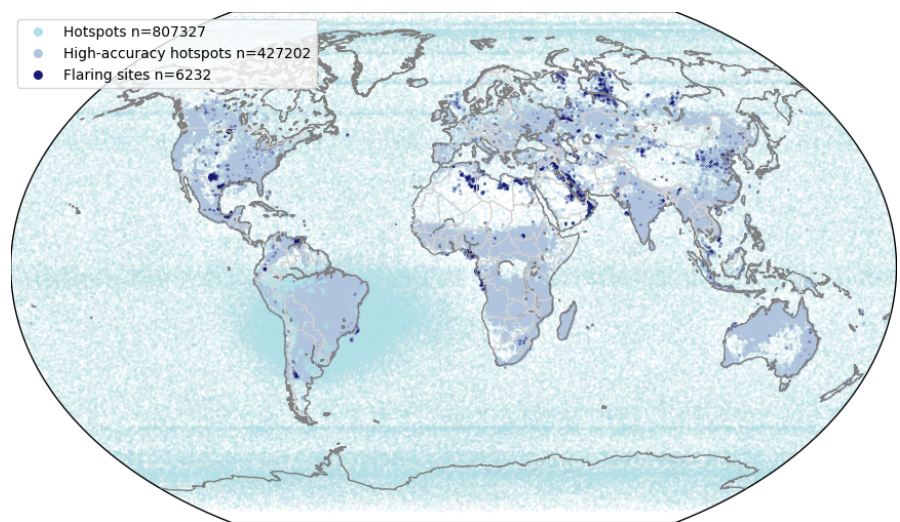
Figure 4. Location of all the 807327 hot spots (all detection databases filtered for spurious signals; see Fig. 1), of all the 427202 high- accuracy hot spots (hot spots filtered for cloudiness and accuracy of the Planck curve fitting; see Fig. 1) and of all the 6232 flaring locations (grid cells with at least 5 high-accuracy hot spots and a maximum retrieved temperature above 1500K) detected in 2017.